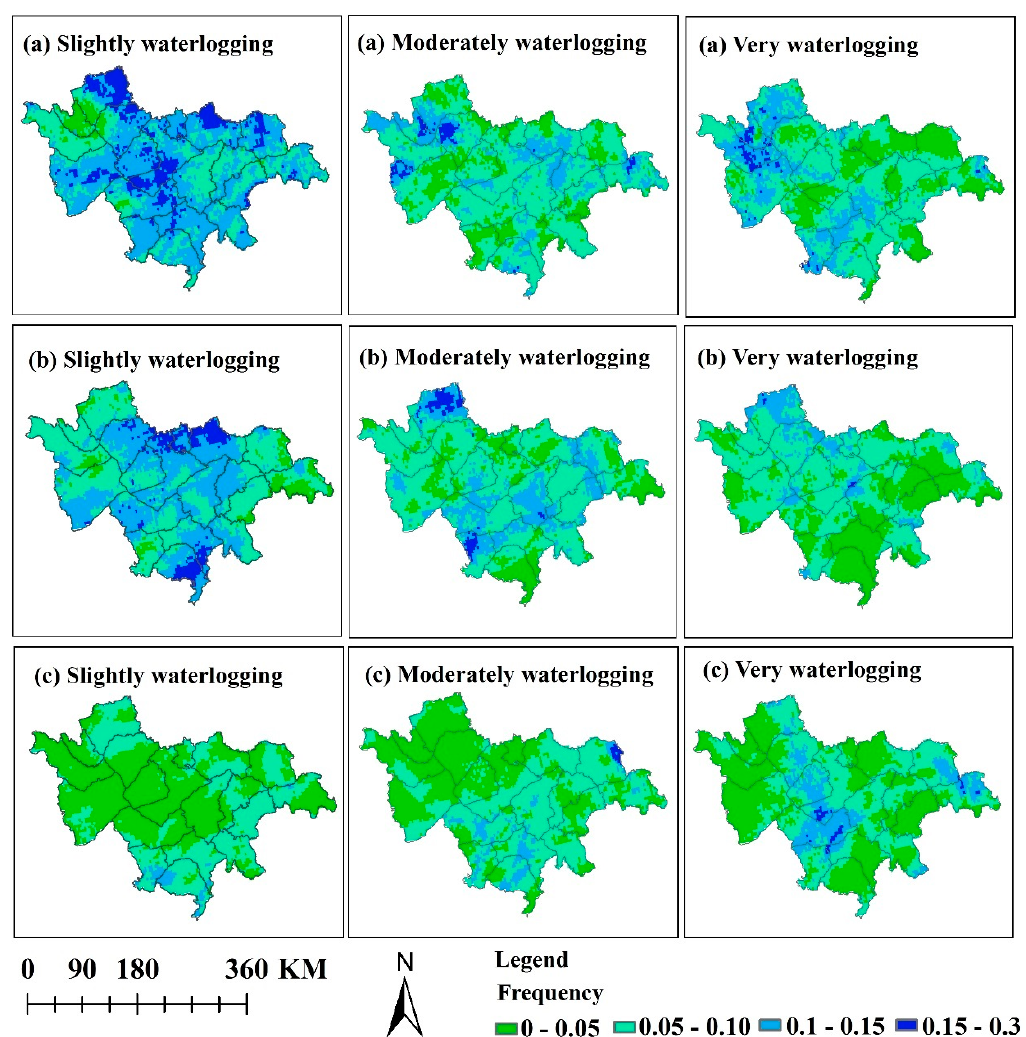
Figure 9. Spatial pattern of frequency of different waterlogging grades based on the CDWI from 1982 to 2015 at different stages in Midwestern Jilin Province. ( a – c ) Represent the stages of emergence-tasseling stage, tasseling-milky maturity, and milky maturity-mature, respectively.